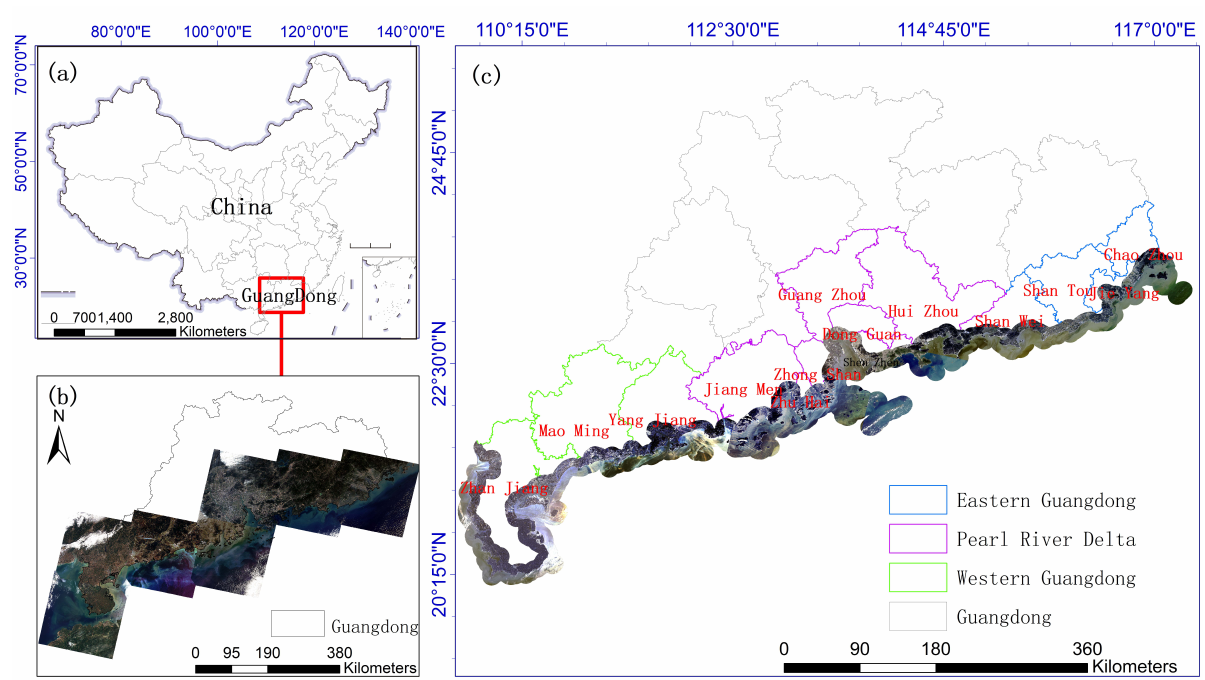
Figure 1. ( a ) Location of Guangdong Province; ( b ) false-color composite image (R, G, B = 3, 2, 1) covering coastal Guangdong collected in 2019; ( c ) false-color composite image (R, G, B = 3, 2, 1) covering the study area in 2019, with the overlay of municipal administrative boundaries.